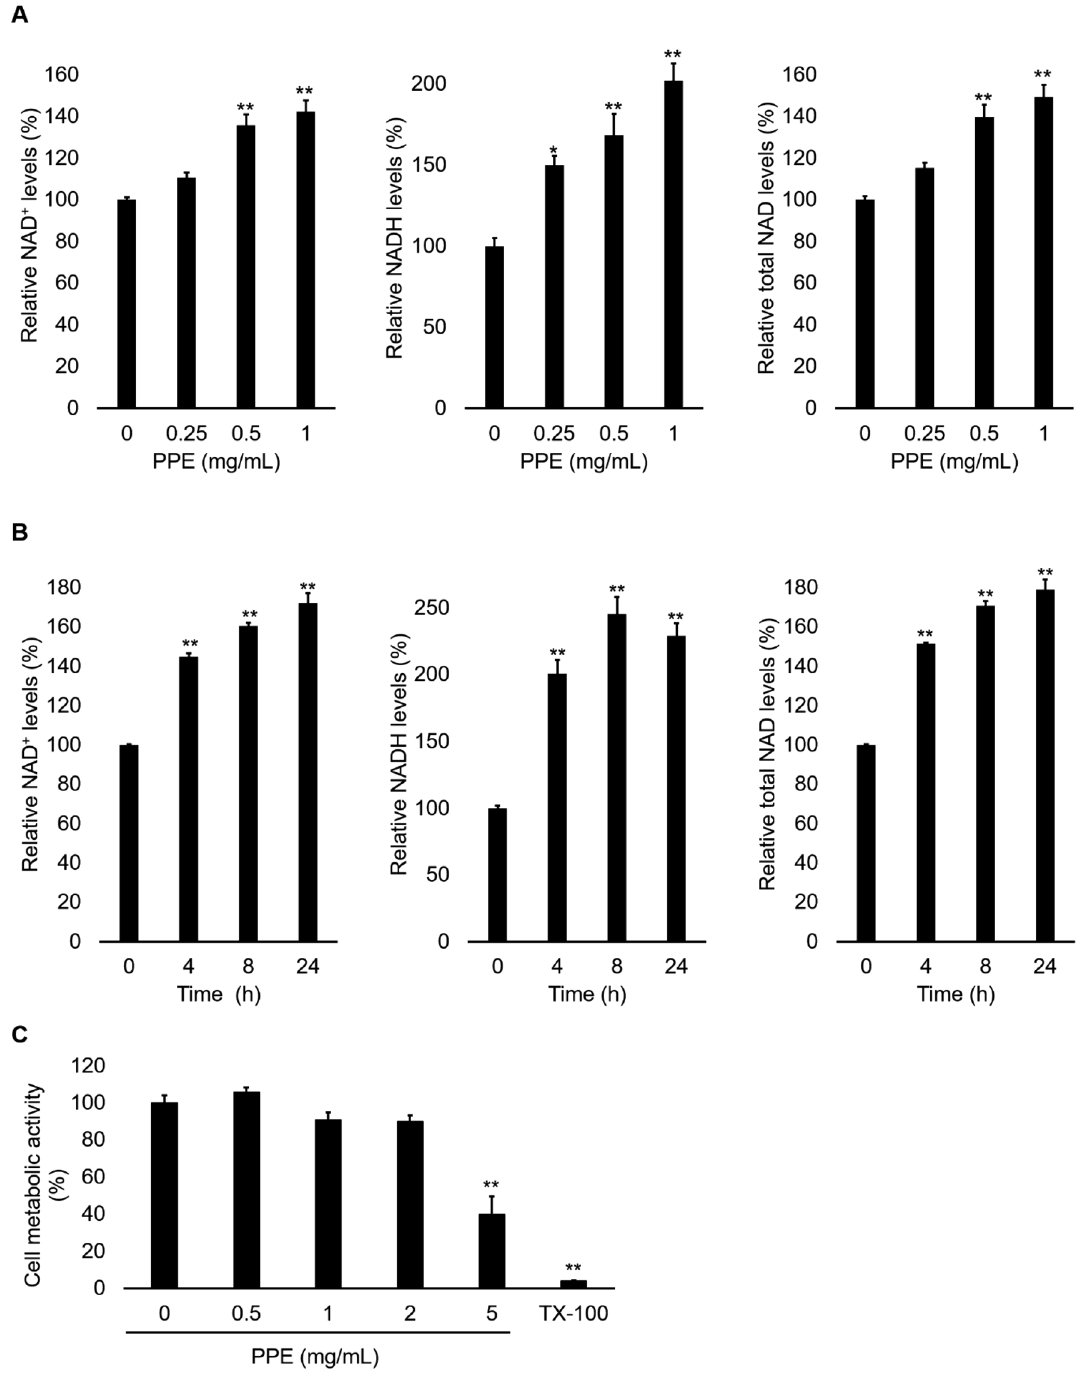
Figure 1. PPE increases cellular NAD levels in NHEKs. The NHEKs were incubated with PPE at the indicated concentration or 0.2% TX-100 (as the positive control) for 24 h ( A,C ) or 1 mg/mL PPE for the indicated time ( B ). The cellular NAD + , NADH, and total NAD levels were determined using NAD + /NADH assay kit. The cell metabolic activity was determined using the MTT assay. * p < 0.05 and ** p < 0.01, in comparison with the